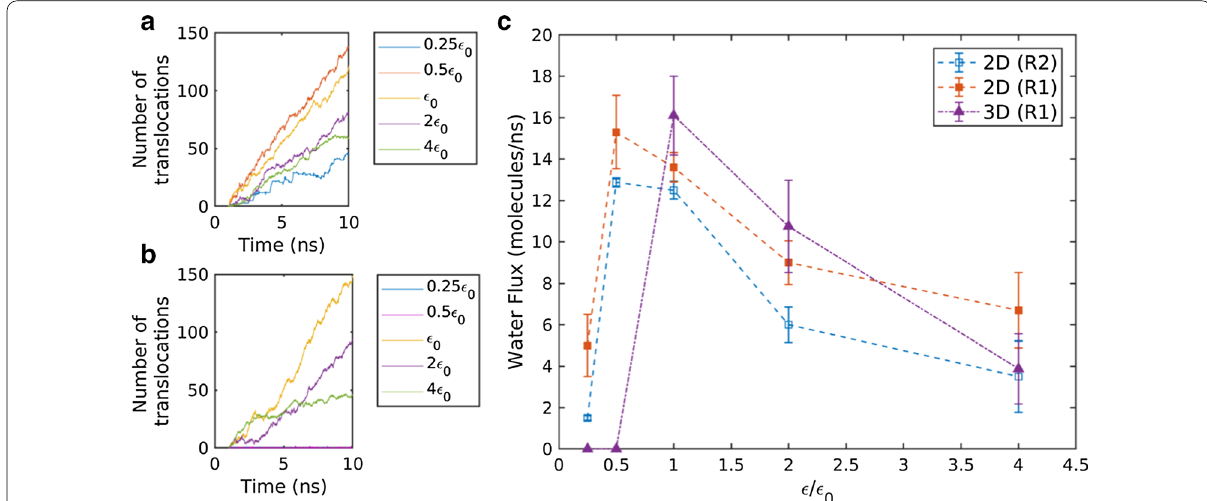
Fig. 2 a Number of translocated water molecules with time in 2D membranes, b number of translocated water molecules with time in 3D membranes, c calculated water flux (number of translocated water molecules per ns) variation with the water–membrane interaction